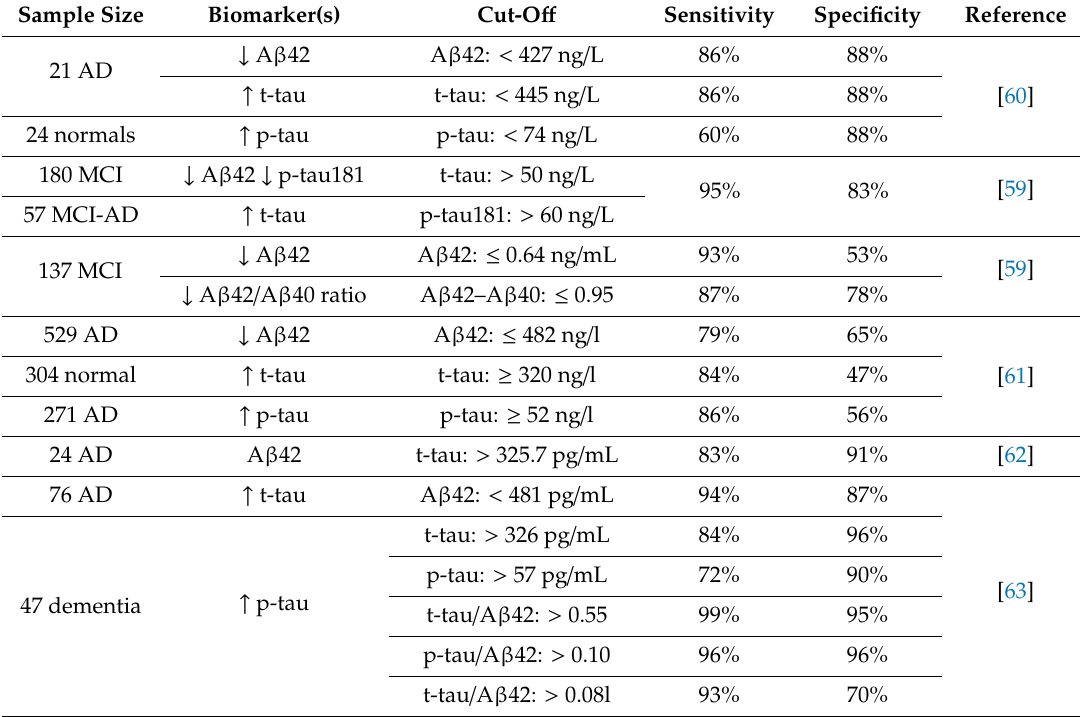
Table 1. The presence of A β 42, p-tau and t-tau in CSF corresponds with pathology as core